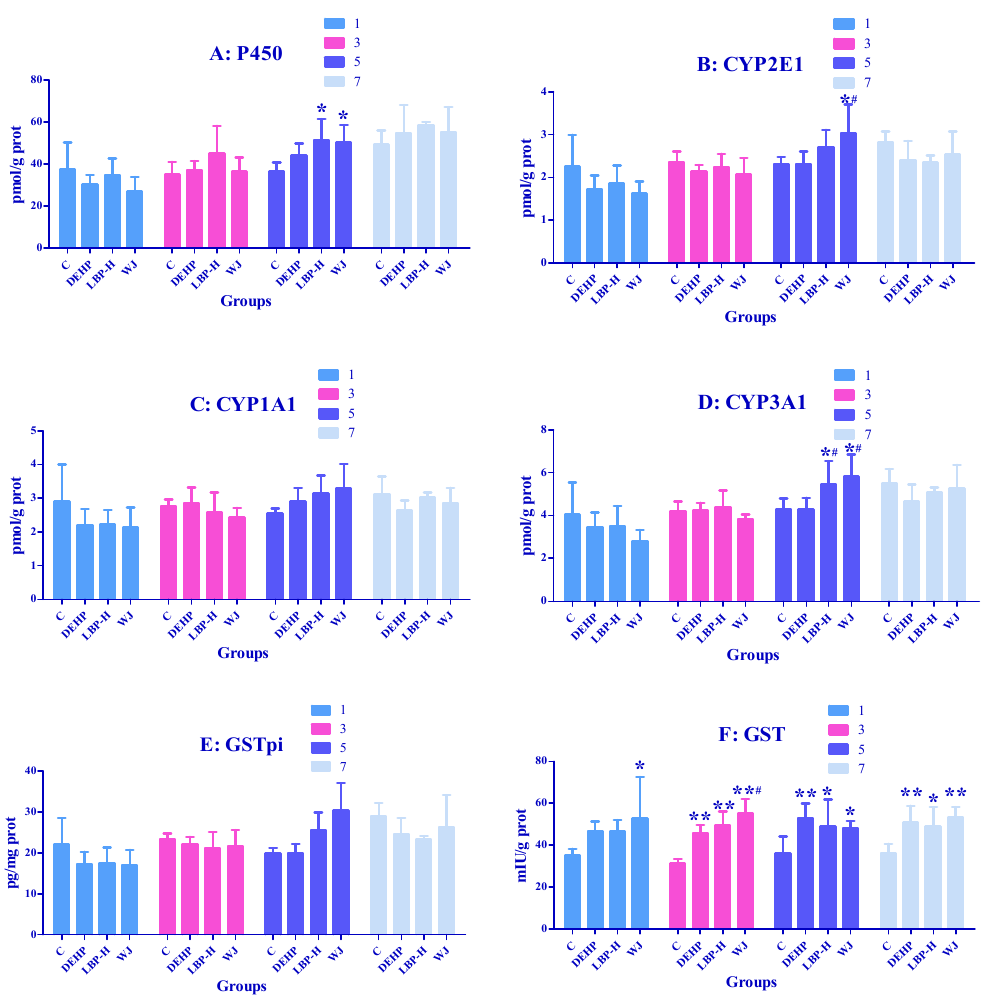
Figure 6. Effects of LBP and WJ intervention on liver metabolic enzyme exposed to DEHP activity in rats ( n = 5). After one day of DEHP feeding, LBP and WJ were used for continuous intervention, and the liver metabolic enzymes (CYP450, CYP2E1, CYP1A1, CYP3A1, GSTpi, and GST) were measured by ELISA kit on the first, third, fifth, and seventh day of intervention. ( A – F ): concentrations and activities of CYP450, CYP2E1, CYP1A1, CYP3A1, GSTpi, and GST in liver, respectively. Note: data are expressed by mean ± S.D. The significance of differences among treatment groups was determined by one-way ANOVA. * or **: compared with control group, p < 0.05 or 0.01; # or ## : compared with DEHP group, p < 0.05 or 0.01.